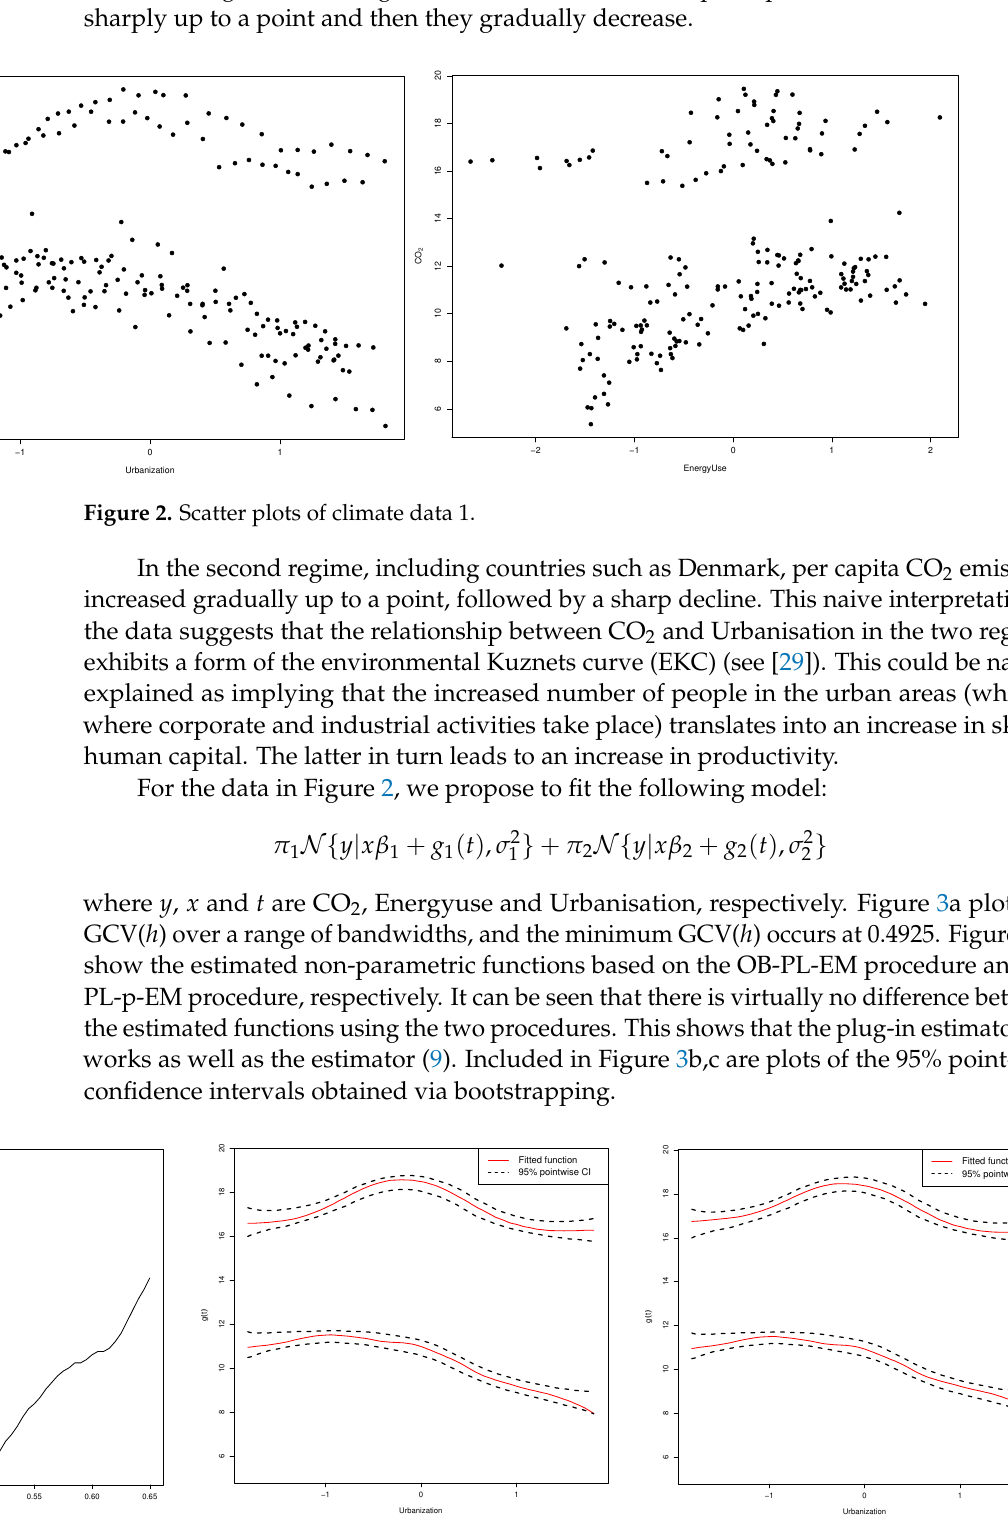
Figure 3. Fitted model (38): ( a ) The GCV plot over a range of bandwidths with a minimum at h = 0.4925. ( b ) estimated non-parametric functions (red solid lines) ˆ g k ( t ) : k = 1,2 based on the OB-PL-EM procedure and ( c ) the same as in ( b ) using the PL-p-EM procedure. The dashed lines are the 95% point-wise confidence